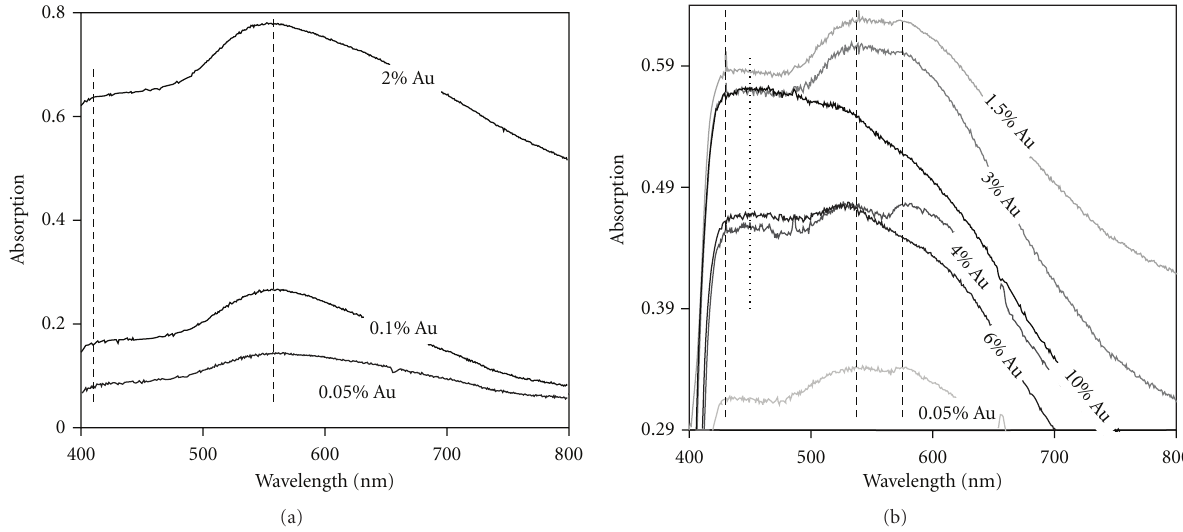
Figure 7: Exemplary DRS of Au/TiO 2 : TIO-10 (a) and Aldrich R (b) for di ff erent amounts of deposited